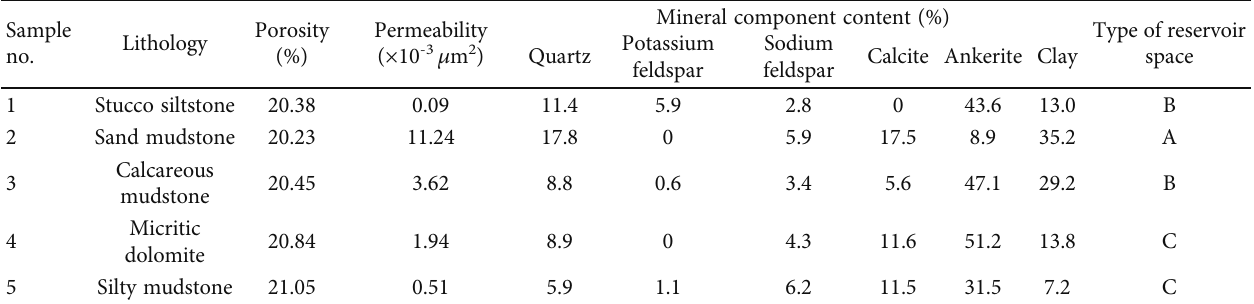
Table 1: Reservoir physical properties and petrological parameters of rock